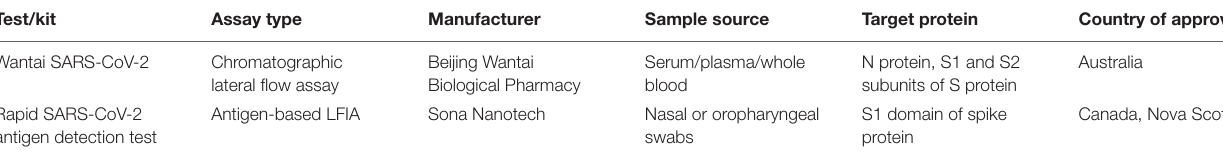
TABLE 3 | Serological assays using viral spike protein to diagnose SARS-CoV-2 infection. Test/kit